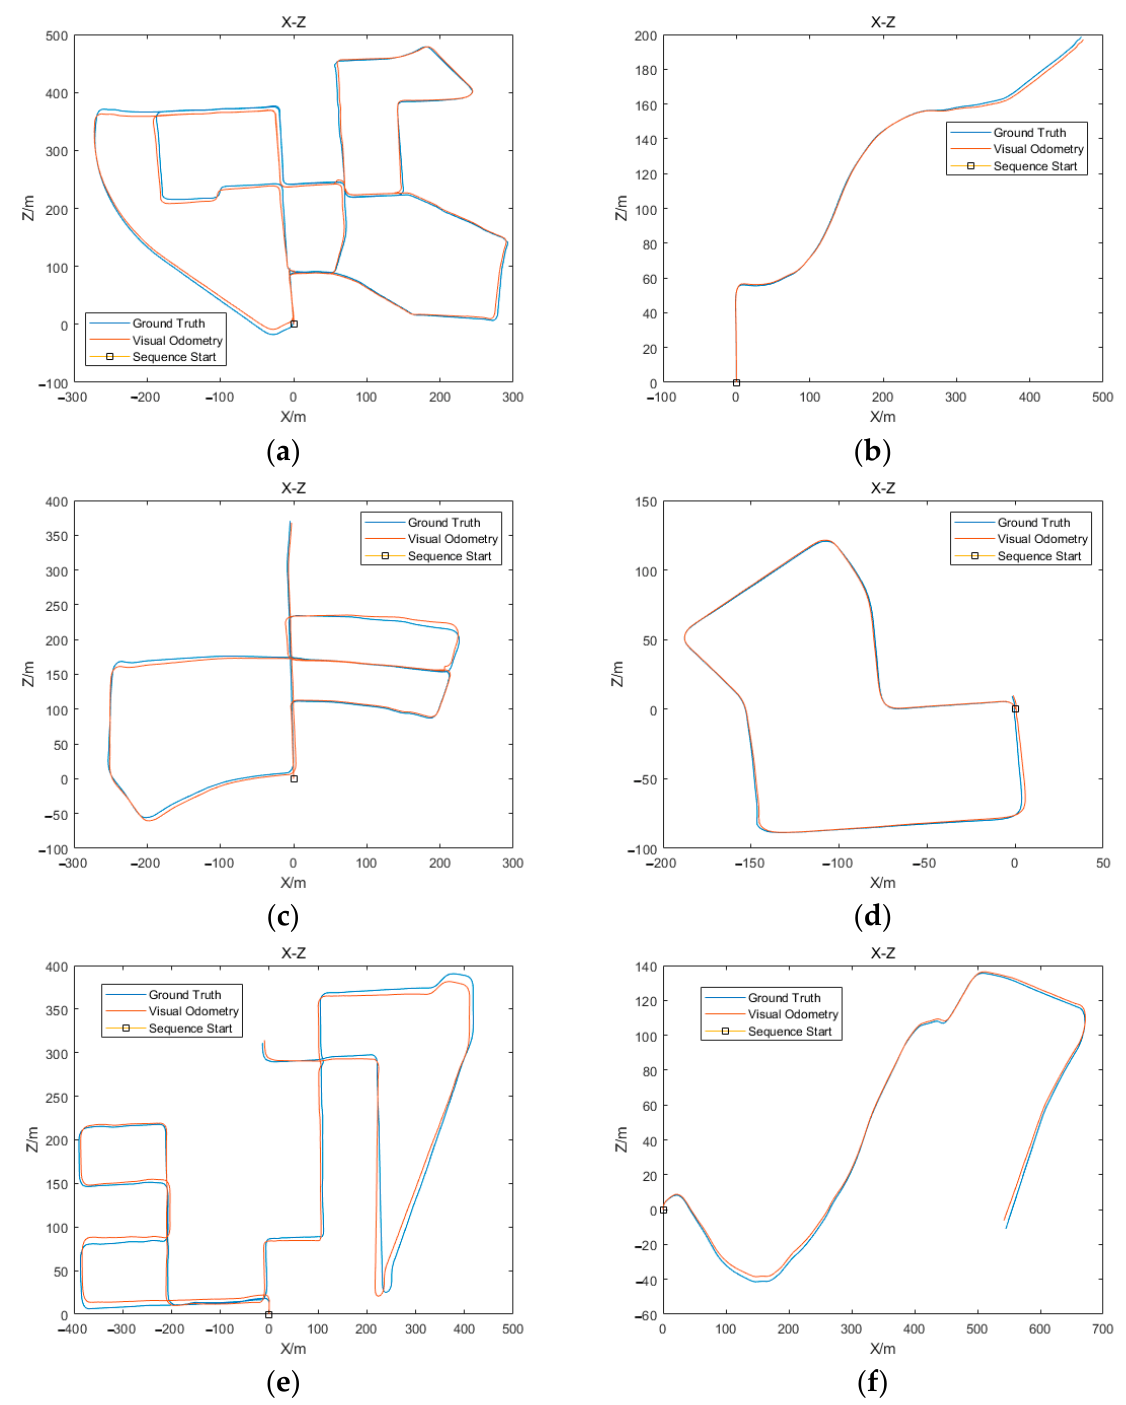
Figure 7. Reconstructed path for ( a ) sequence 00; ( b ) sequence 03; ( c ) sequence 05; ( d ) sequence 07; ( e ) sequence 08; and ( f ) sequence 10. Table 1. Comparison of the proposed method to a version that determines the AKT window size using only disparity information on the KITTI dataset. (deg/m stands for degrees per meter).